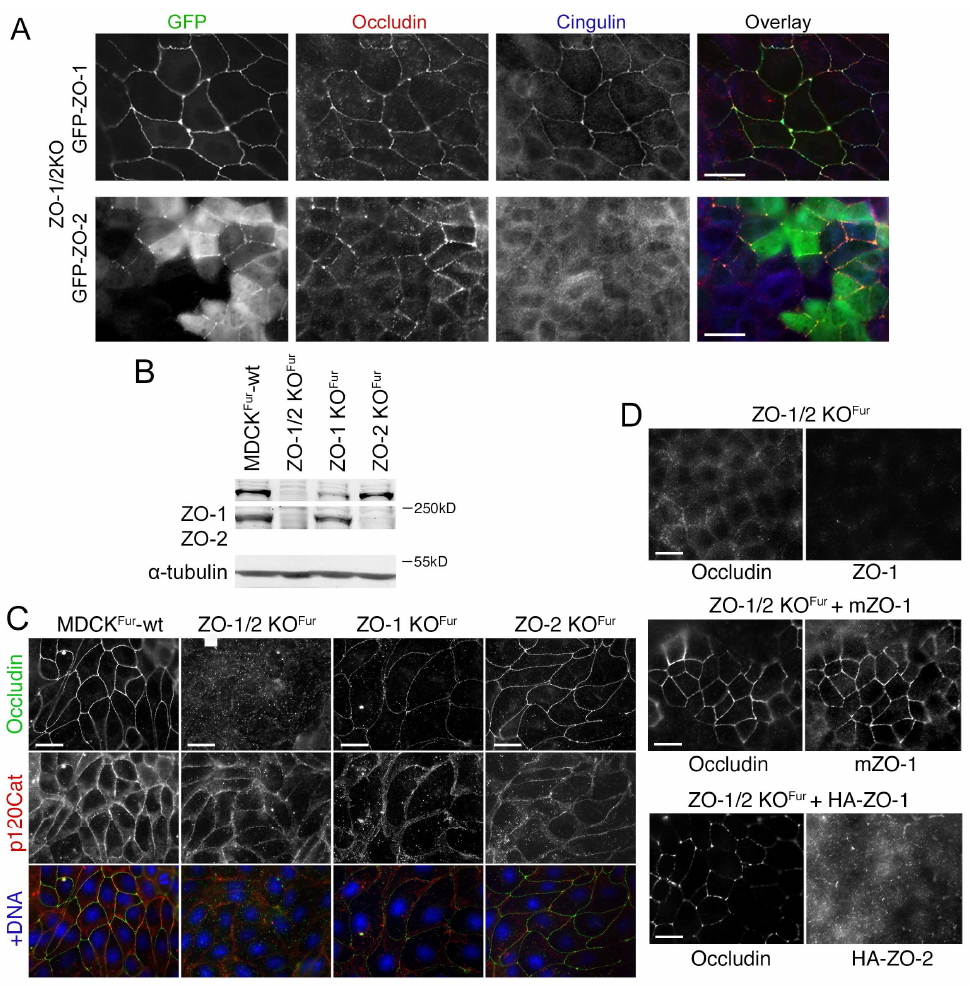
Figure 8. ZO-1 and ZO-2 have distinct functions in TJ assembly. ( A ) Double knockout cells were transfected with GFP-ZO-1 or GFP-ZO-2 and TJ formation was analysed by immunostaining occludin and cingulin. Note, only GFP-ZO-1 induced normal distribution of TJ proteins (see Figure S7C for expression of GFP-ZO-2 in wild-type MDCK cells. ( B , C ) Wild-type and knockout MDCKFur cells were analysed by immunoblotting to monitor expression of ZO-1 and ZO-2 ( A , antibodies against epitopes in the C-terminal domain of the ZO proteins was used as in Figure 4C) or immunofluorescence to analyse junction formation ( B ). ( D ) ZO-1 and ZO-2 were re-expressed in ZO1/2 knockout MDCKFur cells followed by staining for occludin to monitor TJ formation. Magnification bars, 20 μ m.